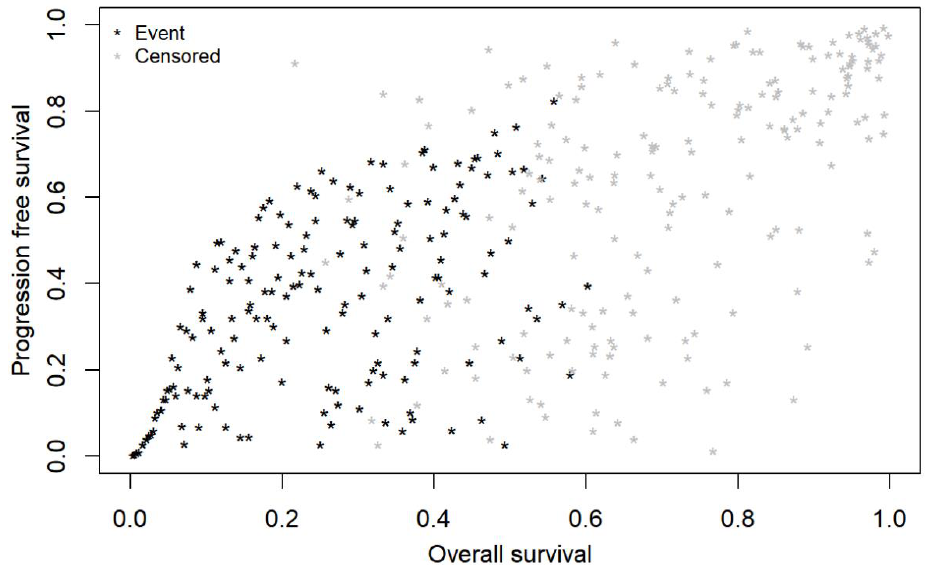
Figure 3. Bivariate copula plot depicting correlation between real-world overall survival (rwOS) and real-world progression-free survival (rwPFS) of patients with advanced melanoma treated with first-line